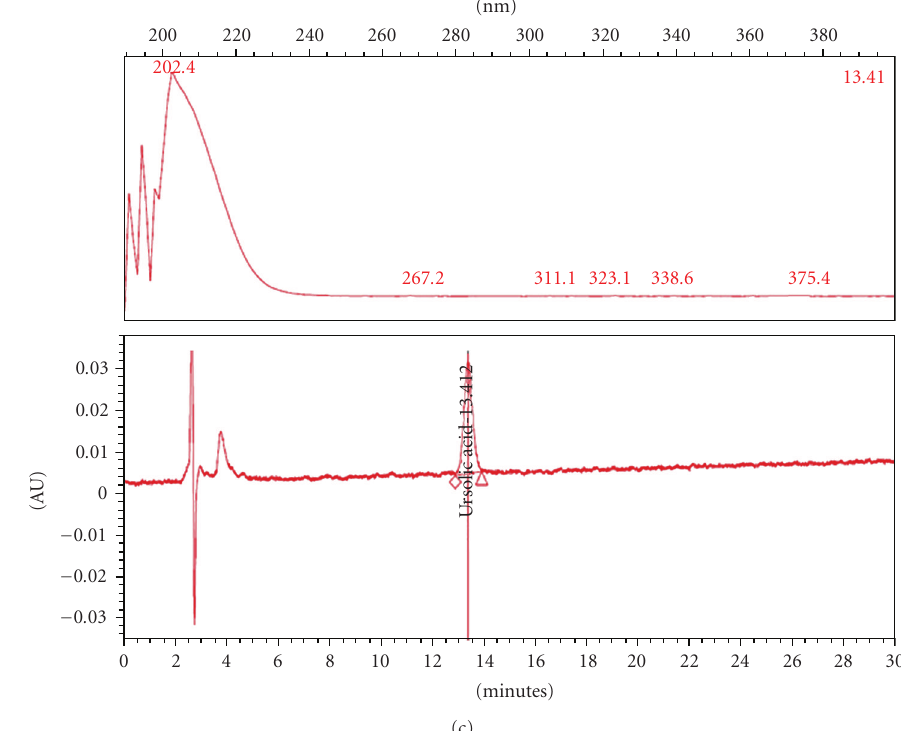
Figure 7: HPLC (high performance liquid chromatography) fingerprint of ethanol extract and its CH 2 Cl 2 fractions. A. koreanum ethanol extract (a) and its CH 2 Cl 2 fractions (b) were analyzed by HPLC. The lower side (c) represents standard ursolic acid. Ursolic acid exhibits peak absorbance at 203-204